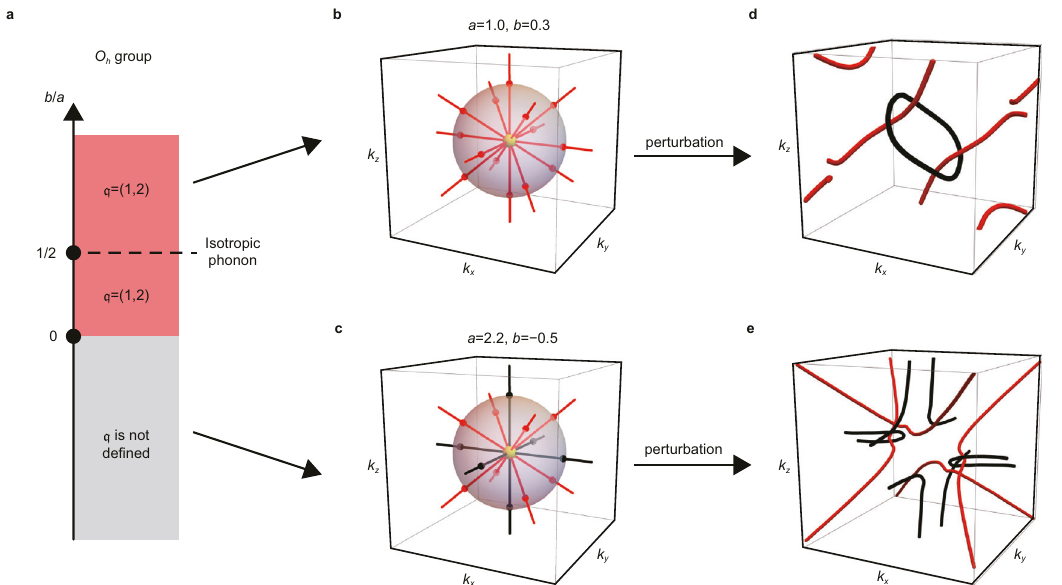
Fig. 3 Acoustic triple points in cubic systems. a Phase diagram for the elastic continuum Hamiltonian in Eq. (2) for acoustic phonons in cubic systems. b , c Nodal structure for b / a > 0 ( b ) and b / a < 0 ( c ). The black (red) lines are band degeneracies between the upper (lower) two bands. Notice that there are two types of nodal lines, one along the k x , k y , and k z axes and another along the lines that satisfy ∣ k x ∣ = ∣ k y ∣ = ∣ k z ∣ . For b / a > 0, the band degeneracies occur only between the lower two bands. However, the eigenvalues of the degenerate bands along the k x , k y , and k z axes increase as b / a decreases, so that when b / a < 0, these degeneracies occur between the upper two bands instead of the lower two bands. When we perturb the Hamiltonian in b such that the conditions required to obtain the symmetry-protected TATP are broken, while the conditions needed to de fi ne q are kept, we obtain d . Notice that the nodal ring (black) formed between the upper two bands are penetrated by two nodal lines formed between the lower two bands. This should be compared with e , in which we do not obtain a linked nodal ring structure as in d , although we similarly perturb the Hamiltonian in c